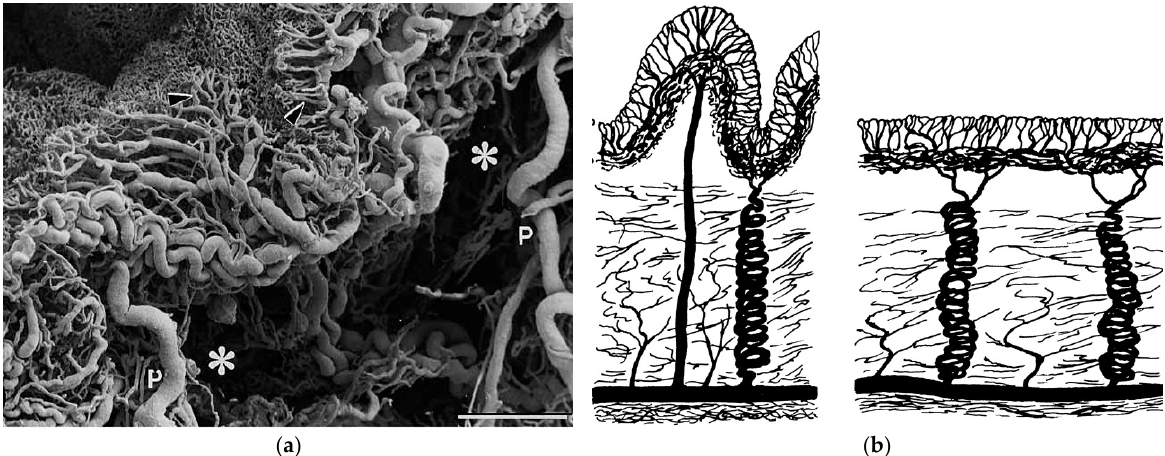
Figure 2. Diagram of the bladder vessel microarchitecture. ( a ) Shows the profile of the mucosal layer vasculature obtained via SEM. P—perpendicular vessels originating from the adventitial plexus, *—submucosa. ( b ) Graph showing structure of the vasculature in non distended ( left ) and distended bladder ( right ). Figures obtained with permission from [37].